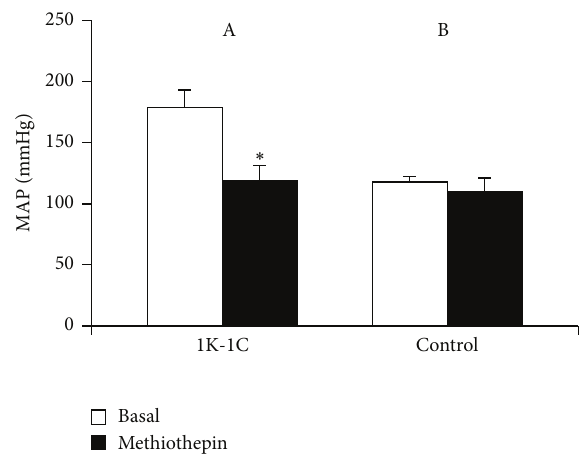
Figure 3: Values of mean arterial pressure (MAP) reached after bilateral microinjection of methiothepin (0.06 mol/L, 100 nL) into the RVLM in 1K-1C ( 𝑛 = 6 ) or control rats ( 𝑛 = 5 ). ∗ 𝑃 < .05 in relation to basal